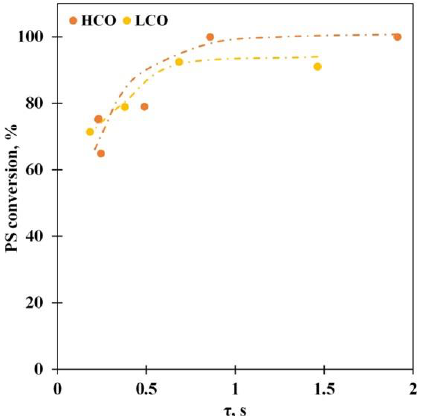
Figure 5. The PS conversion vs. the vapor residence time for the PS solutions in LCO (15% PS) and HCO (10% PS) at 550 °C.